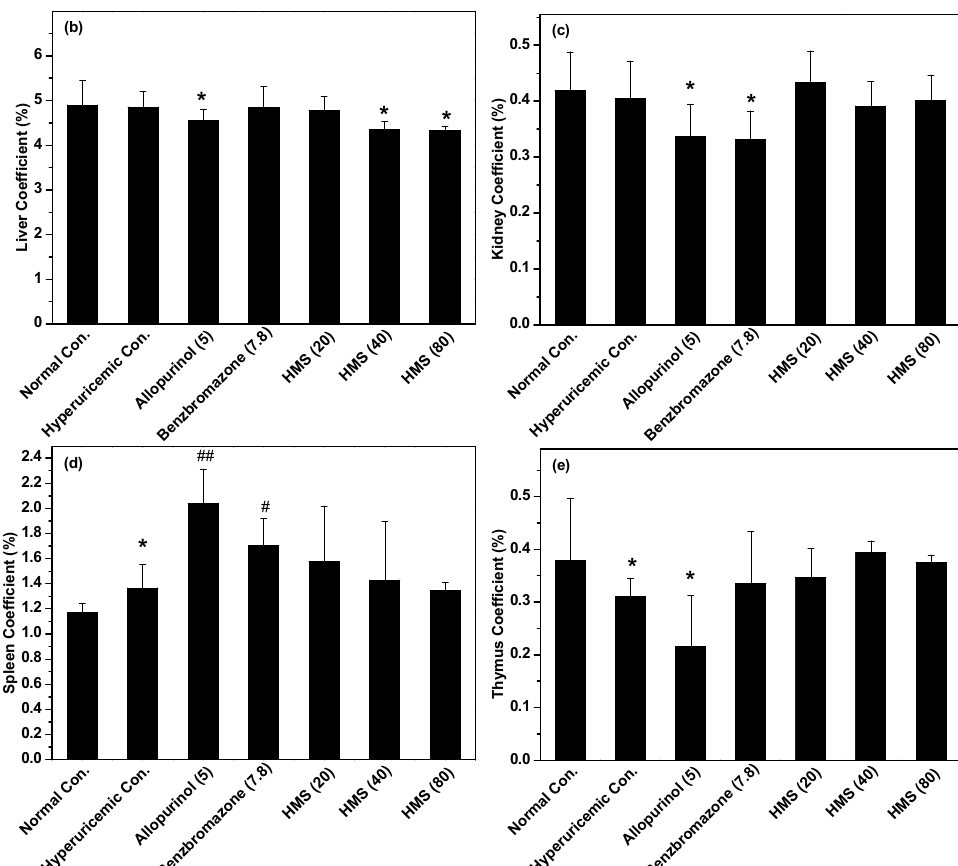
Figure 6. Impacts of allopurinol, benzbromarone and HMS on ( a ) body weight, ( b ) liver ( c ) kidney, ( d ) spleen and ( e ) thymus. Data were expressed as mean ± SD; n = 8. Statistical analysis by one-way ANOVA followed by two-tailed Student’s t -test; * p < 0.05 versus the normal control; # p < 0.05 or ## p < 0.01 versus hyperuricemic control.